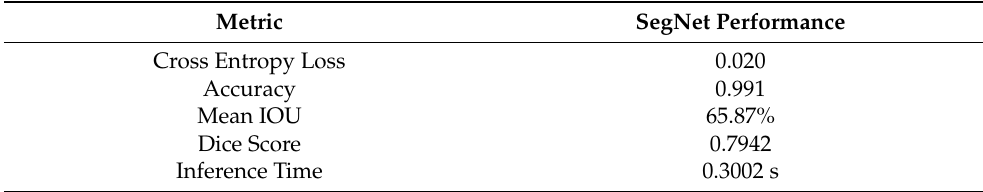
Table 1. Evaluation metrics for our trained SegNet